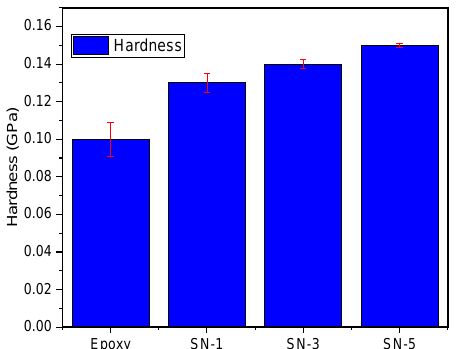
Figure 4. Indentation hardness of SNP formulated epoxy coatings.